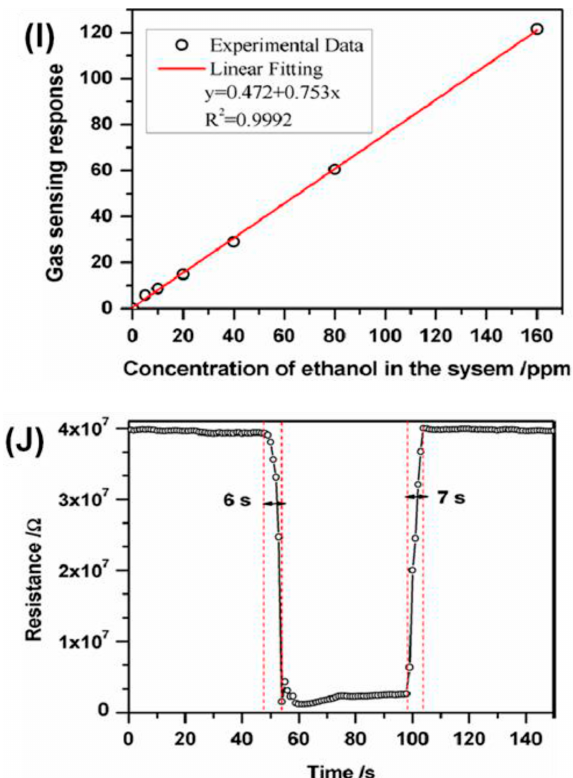
Figure 9. SEM images of the samples: precursor ( A , B ); ZnO-350 ( C , D ); ZnO-450 ( E ); and ZnO-550 ( F ), the inset in C presents a hollow structure of the ZnO-350; ( G ) ZnO sensors response to 50 ppm ethanol under different operating temperature; ( H ) Response of ZnO-350 dandelion-like hierarchitectures toward 50 ppm of different interfering molecules at the optimum operating temperature of 250 ◦ C; ( I ) Response curve and linear fitting curve of the sensing response of ZnO-350 to different concentrations of ethanol at the operating temperature of 250 ◦ C; ( J ) response and recovery time of ZnO-350 to 50 ppm ethanol at the operating temperature of 250 ◦ C. Adapted figure from [84] with permission from copyright (2014), American Chemical Society, (Washington, DC, USA).